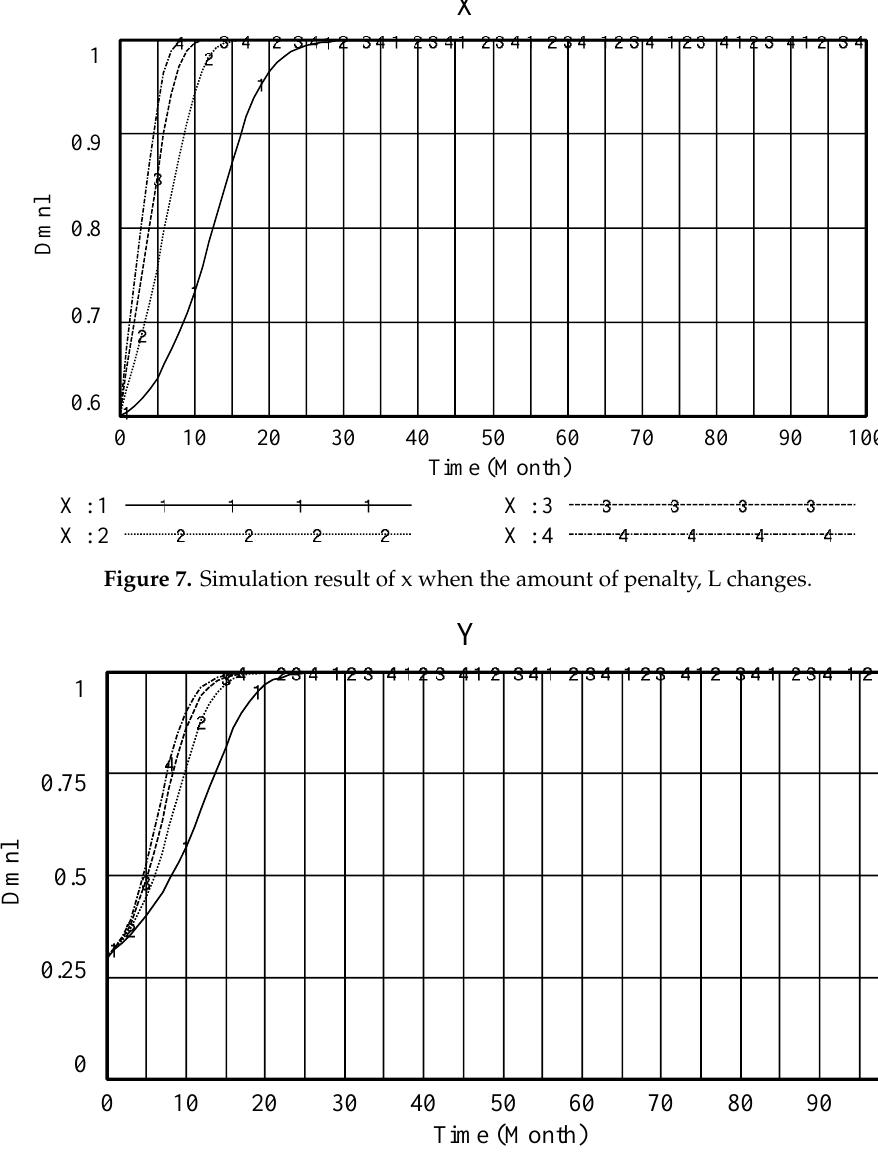
Figure 6. Simulation result of y when initial value of x is 0.6.